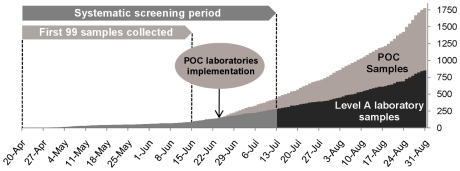
Samples tested from April to August 2009.Panel A corresponds to Level A laboratory samples (N = 99) tested between April 25th 2009 and June 15th 2009. Panel B corresponds to Level A laboratory samples (N = 280) tested between April 25th 2009 and July 13th 2009. Panel C corresponds to all samples (N = 1,815) tested between April 25th 2009 and August 31st 2009, including Point of Care (POC) samples.